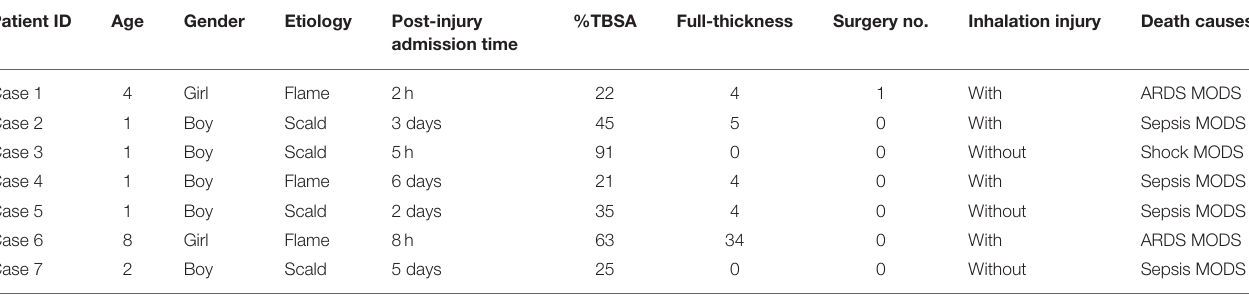
TABLE 8 | The detail of 7